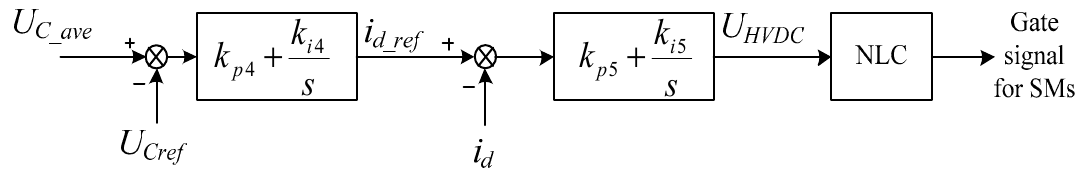
Figure 4. The scheme of DC transmission current controller.